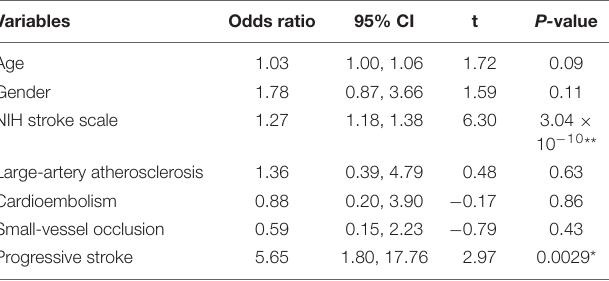
TABLE 2 | Multivariable logistic regression model for predicting patients with dysphagia.